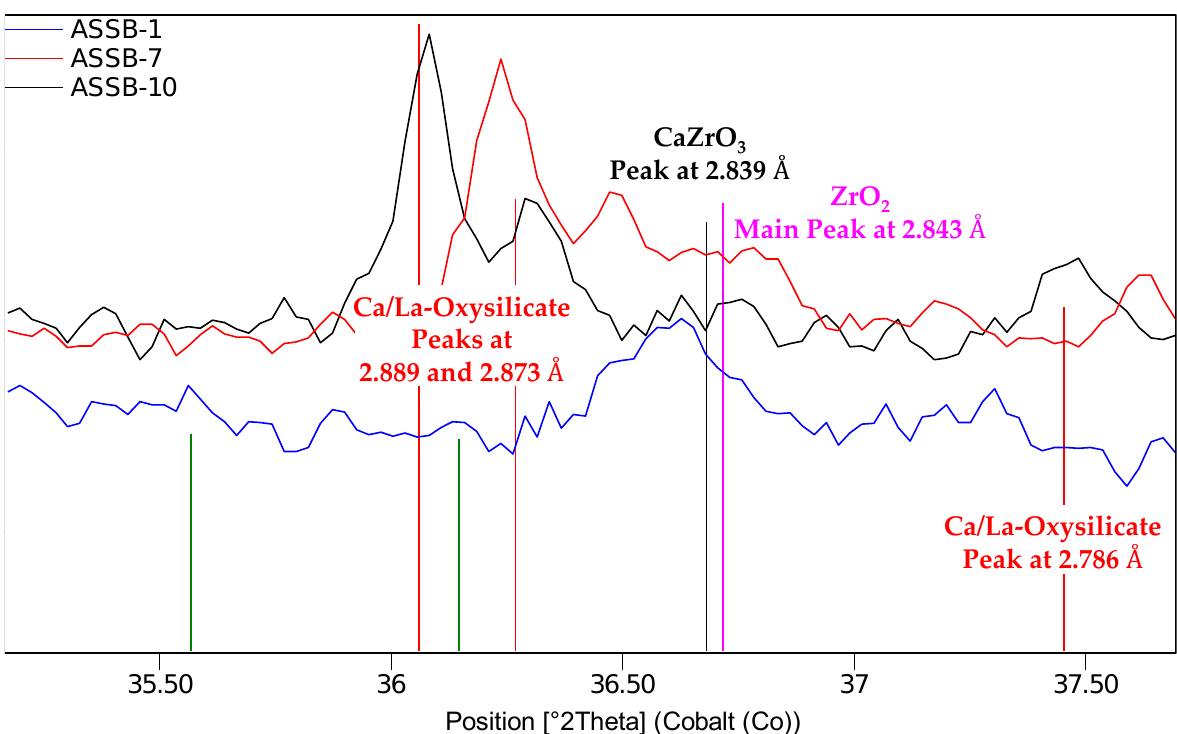
Figure 8. Section of PXRD measurements with the main peaks of Ca/La oxysilicate, britholite, CaZrO 3 , and ZrO 2 (from left to right).